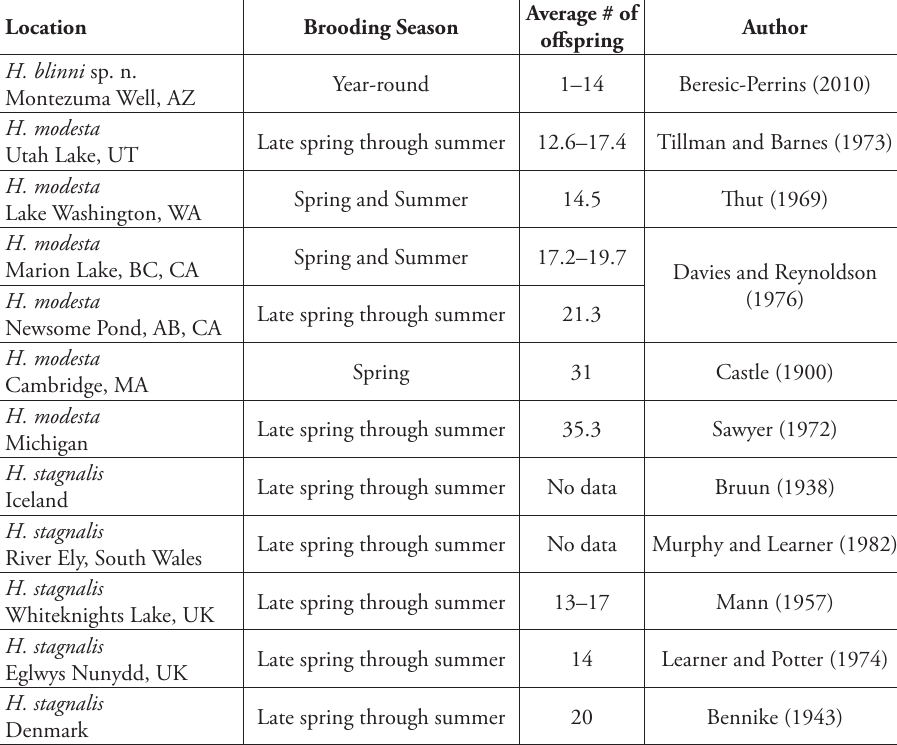
Table 5. Differences in brooding season and size between H. blinni sp. n., H. stagnalis, and H. c.f. modesta.